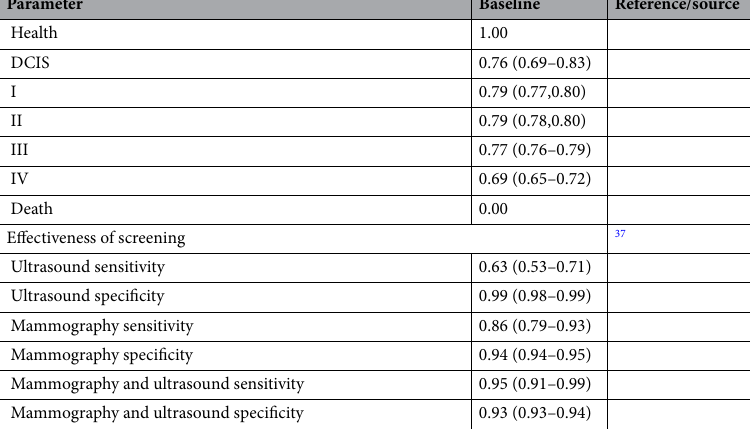
Table 1. Parameter values in the Markov model.